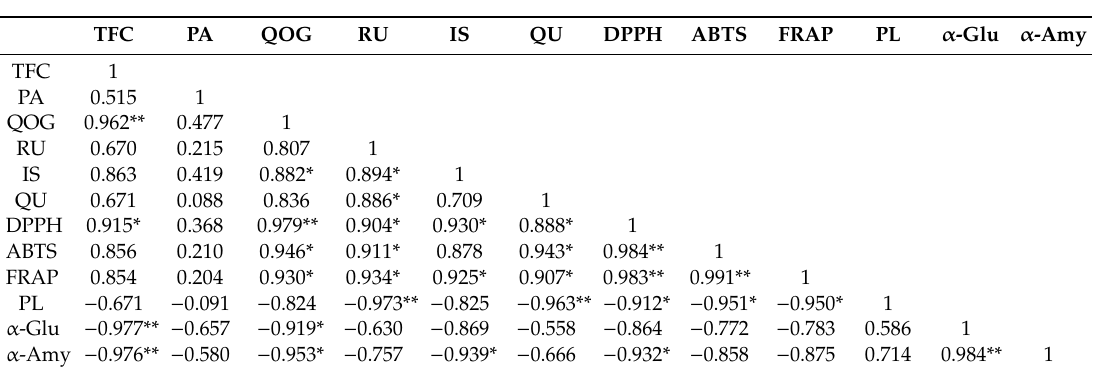
Table 3. Pearson’s correlation coe ffi cients among phenolic compounds, antioxidant capacities, and inhibitory activities on digestive enzymes of di ff erent cultivars of okra